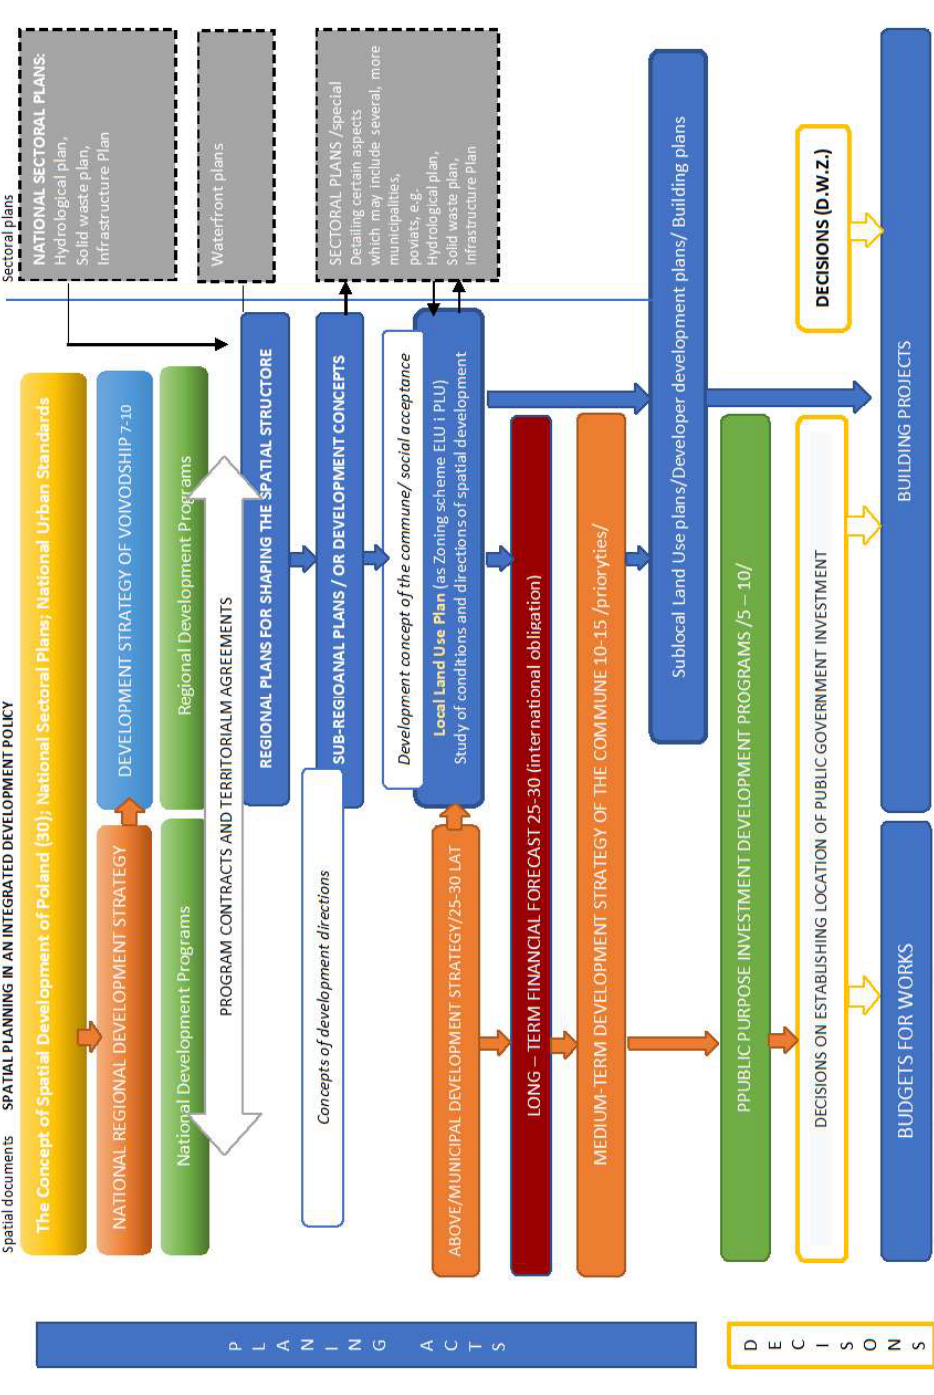
Figure A1. Spatial Planning in an integrated policy in Poland.